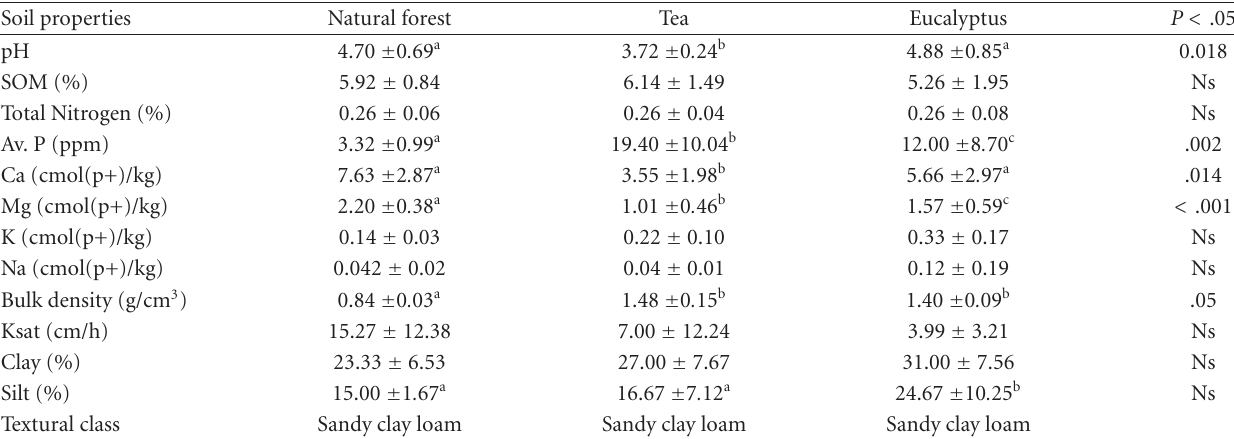
Table 3: Mean ± SD of selected soil (15–30 cm) physical and chemical properties in the three land use/covers.